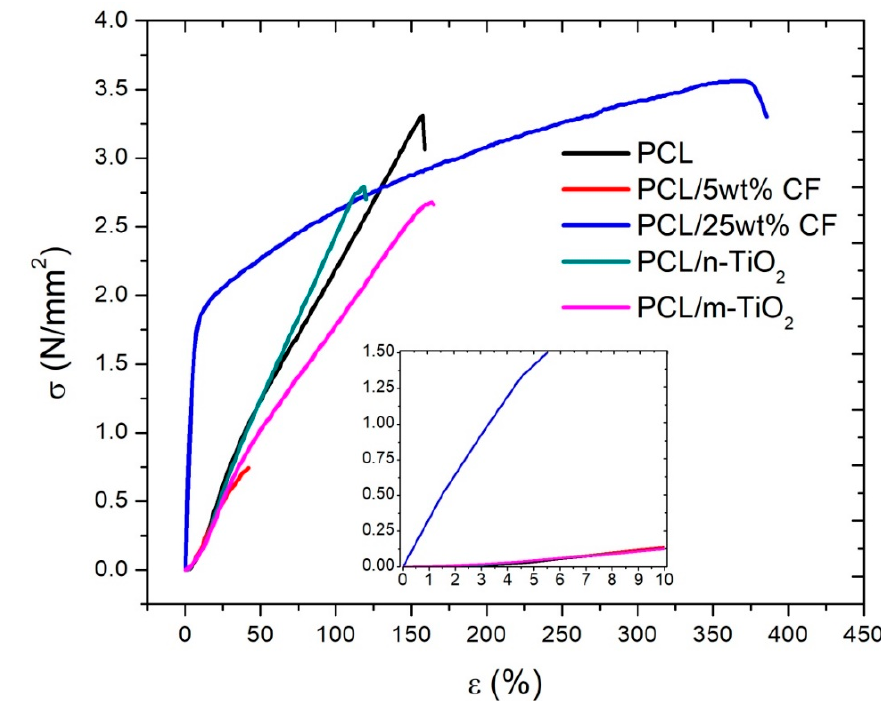
Figure 7. Tensile stress-strain curves of the electrospun scaffolds. Table 2. Maximum force, elongation at break and tensile strength of the electrospun scaffolds. Electrospun Scaffolds F max